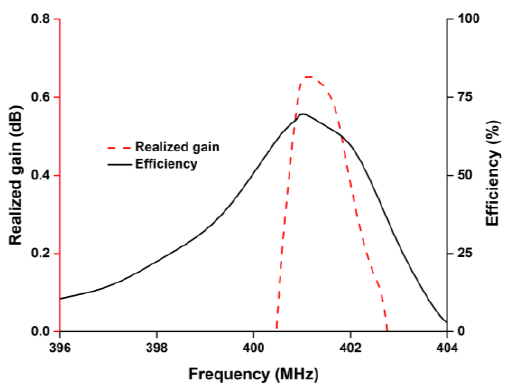
Figure 5. Antenna radiation efficiency and gain pattern with satellite structure.